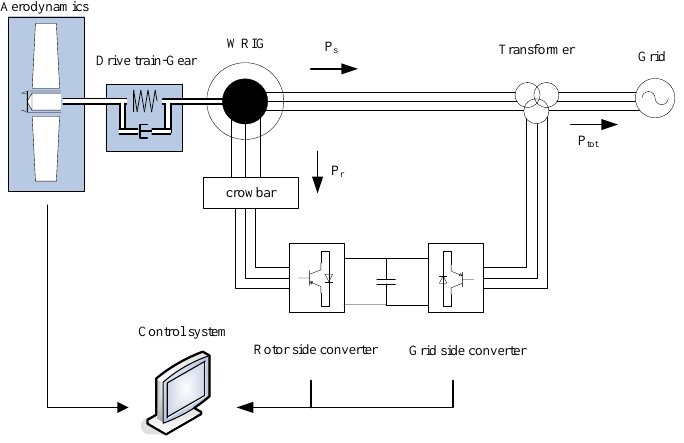
Figure 1. System configuration of a DFIG wind